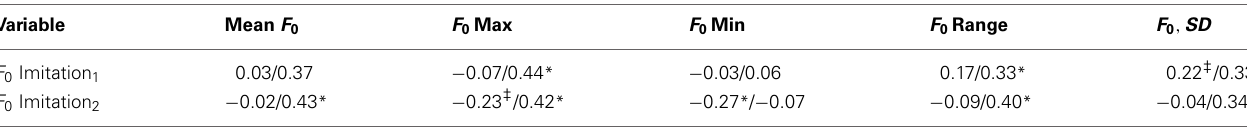
Table 2 | Pearson product-moment correlations between δ p and F 0 imitation in the filtered condition (first value for all participants, second value for participants with PC δ A